Question: Condense the content of this figure into a single sentence.
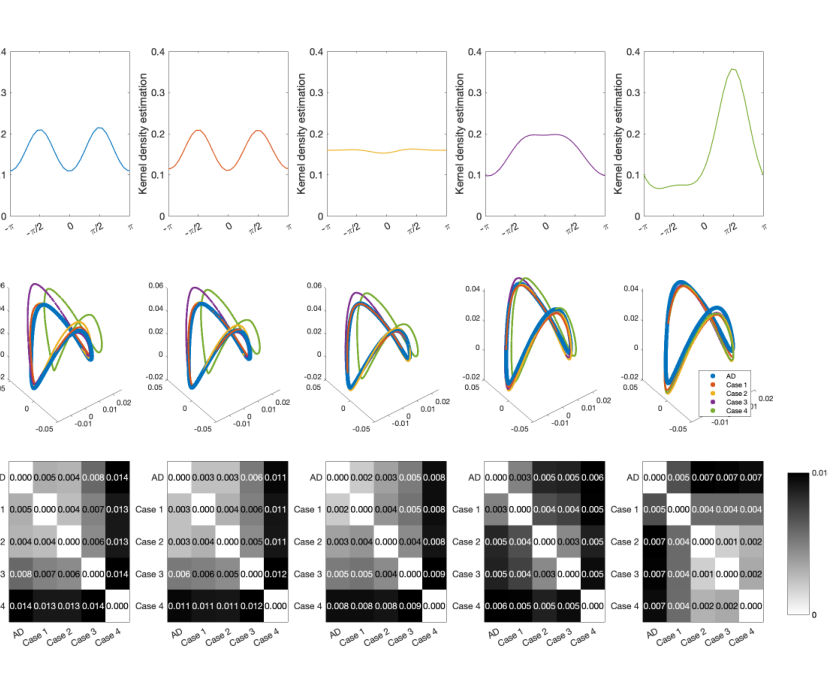
Answer: Illustration of various embeddings by α-LAD under different landmark distributions. Top row, from left to right: the sampling density function p(2) and four landmark distributions, labeled “Case 1” to “Case 4.” Middle row, from left to right: the LAD with α = 0, 1/4, 1/2, 3/4, and 1, respectively. The blue curve is the result of AD, which is the same from left to right. The curves in other colors correspond to different landmark dis- tributions. Lower row, from left to right: the pairwise embedding similarity between different embeddings with α = 0, 1/4, 1/2, 3/4, and 1, respectively.